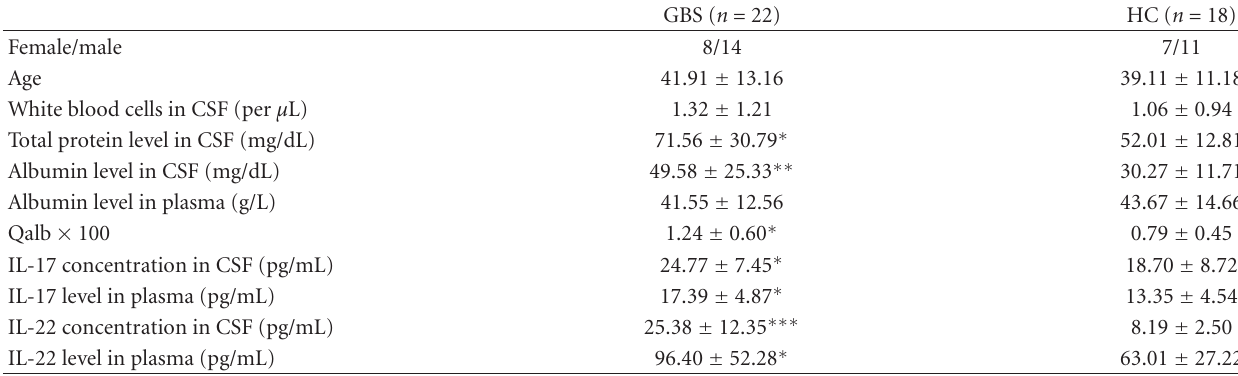
Table 1: Demographic data and IL-17 and IL-22 levels in the cerebrospinal fluid (CSF) and plasma of Guillain-Barr´e syndrome (GBS) patients and healthy controls